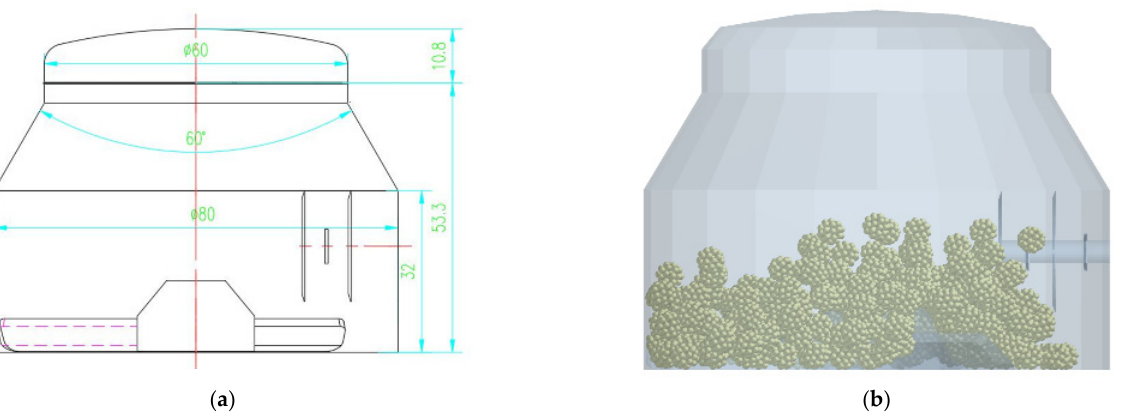
Figure 4. Schematic illustrations of vessel con fi guration ( a ) and initial loading of particles ( b ). The main dimensions are shown in Table 3. The main dimensions are shown in Table Table 3. Key geometric dimensions in the simulation model. Key Geometric Dimension